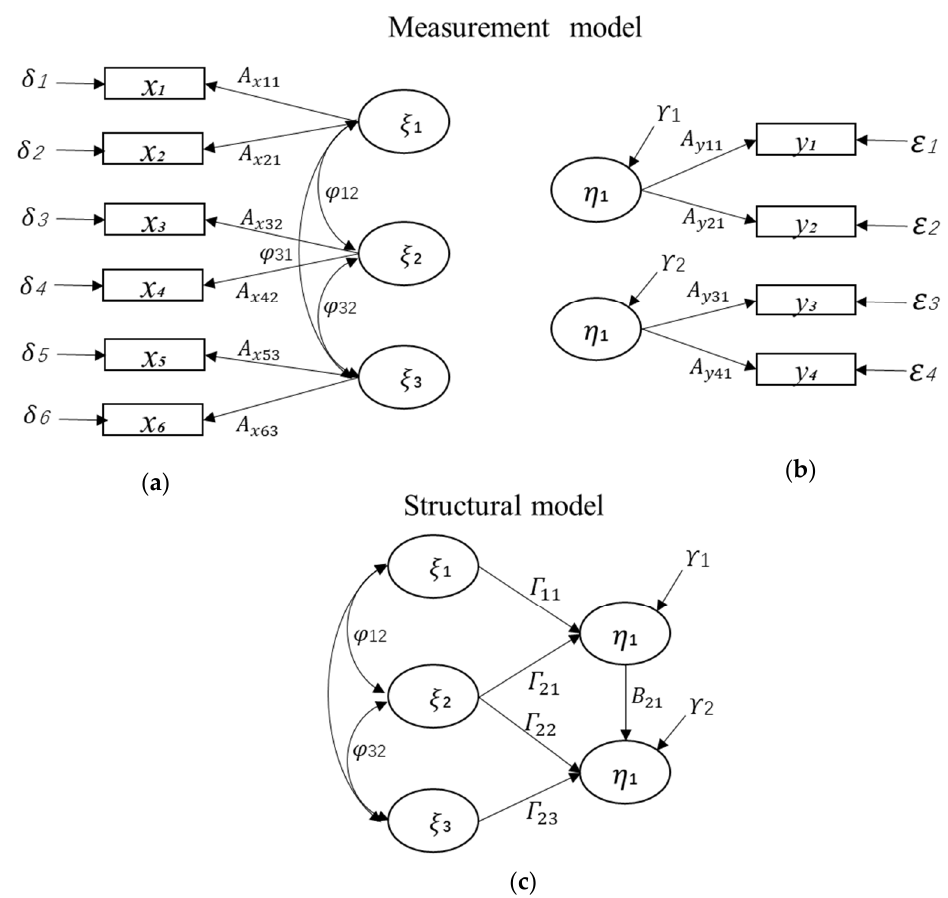
Figure 3. The structural diagram of structural equation model. ( a ) is the measurement model of observables and exogenous latent factors. ( b ) is the measurement model of observables and endogenous latent variables. ( c ) is structural model of exogenous latent factors on endogenous latent factors.